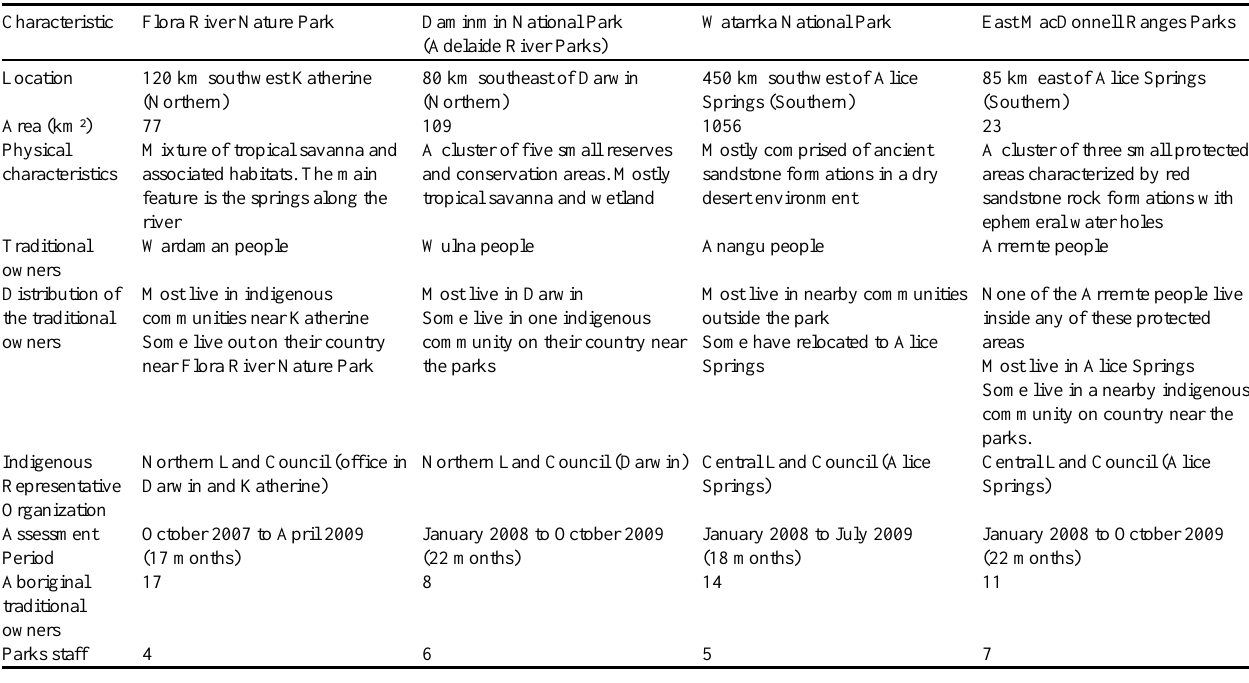
Table 1 . Social and physical characteristics of four jointly managed national parks for which joint management performance indicators were collaboratively developed and evaluated in the Northern Territory, Australia, and the number of interviewees for each park evaluated for